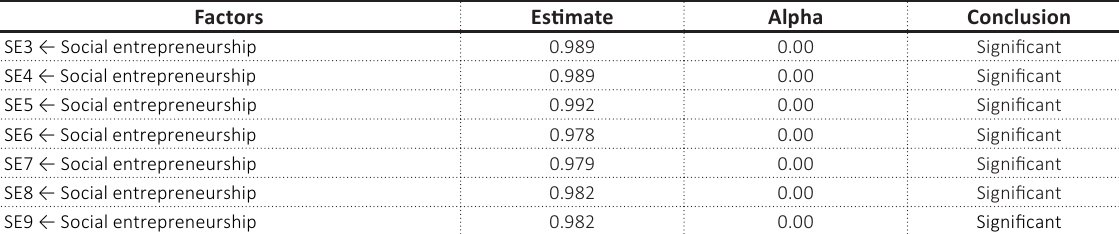
Table 1. Validity of loading factor and significance of social entrepreneurship